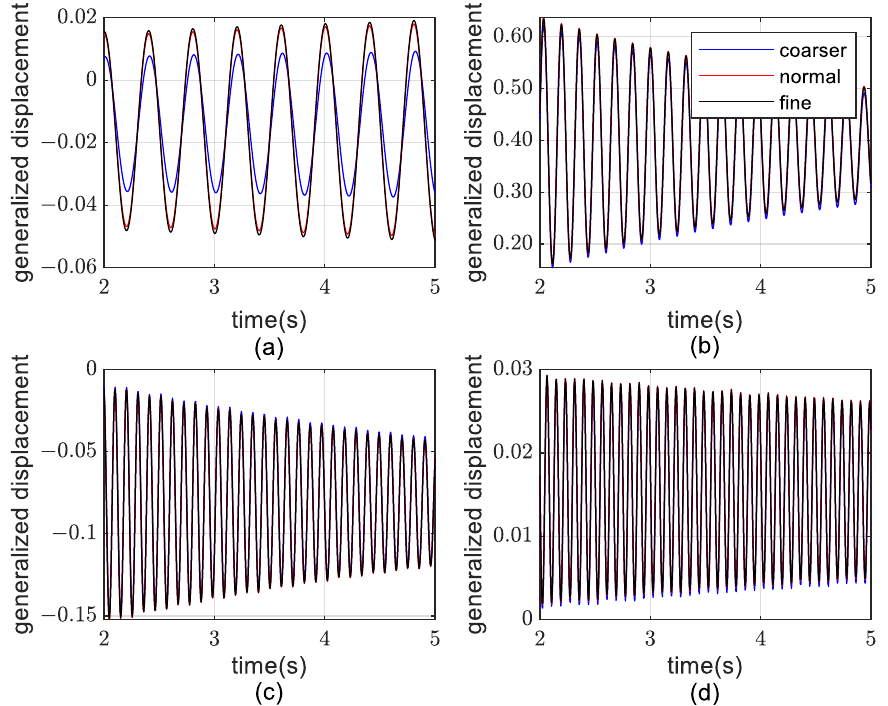
Figure 7. Generalized displacement of the three grid systems. ( a ) First-order mode, ( b ) second-order mode, ( c ) third-order mode, and ( d ) fourth-order mode. Table 3. The number of elements in the three grid systems.